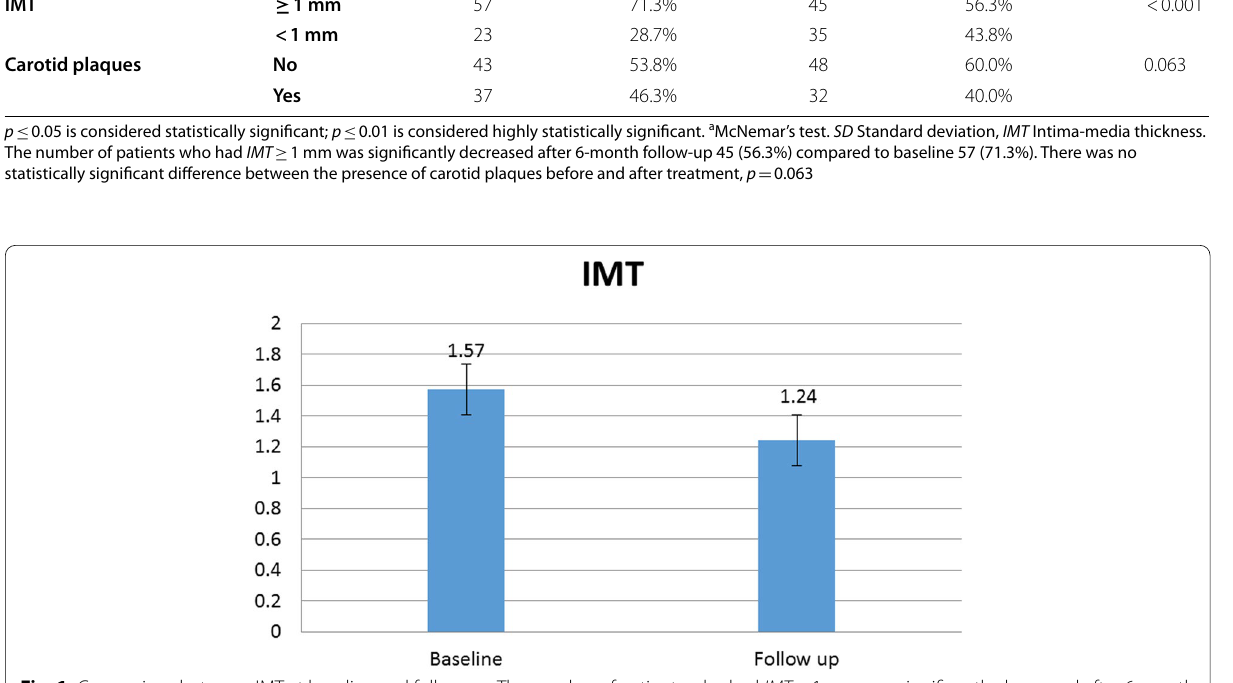
1 mm was significantly decreased after 6-month ≥